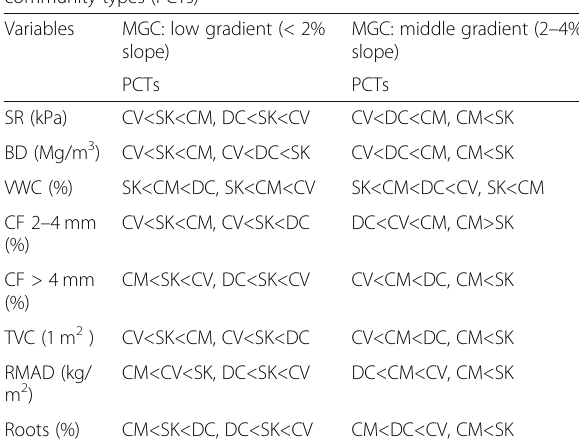
Table 4 Spatial interactions between plant community type (PCT, n = 4) and meadow gradient class (MGC, n = 2) within subalpine meadows sampled ( n = 5) that were significant based on ANOVA ( n = 252 for all variables). Rows display relative ranking of values for that variable for each PCT that were contingent on MGC. Plant abbreviations and wetland status: CV Carex vesiciaria (obligate), DC Deschampsia cespitosa (facultative- wetland), CM Calamagrostis muiriana (facultative), SK Stipa kingii (facultative-upland). Acronyms and abbreviations: SR soil resistance, BD bulk density, VWC volumetric water content, CF coarse fragment content in two size classes (2 – 4 mm and > 4 mm), TVC total vegetation cover determined in 1 m 2 plots